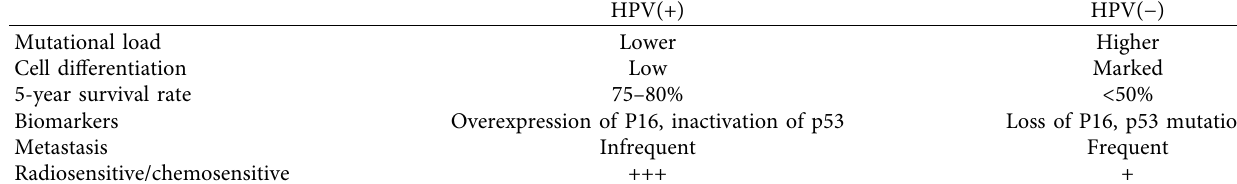
Table 1: Prognostic difference between HPV(+) and HPV( − ) HNSCC.